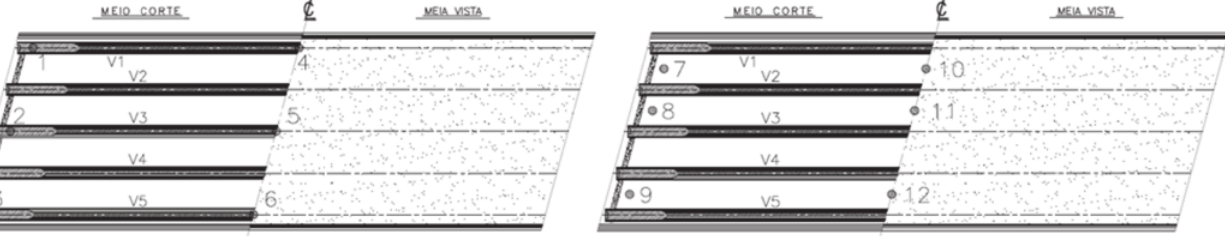
Critical locations for reinforcement design on multi-girder